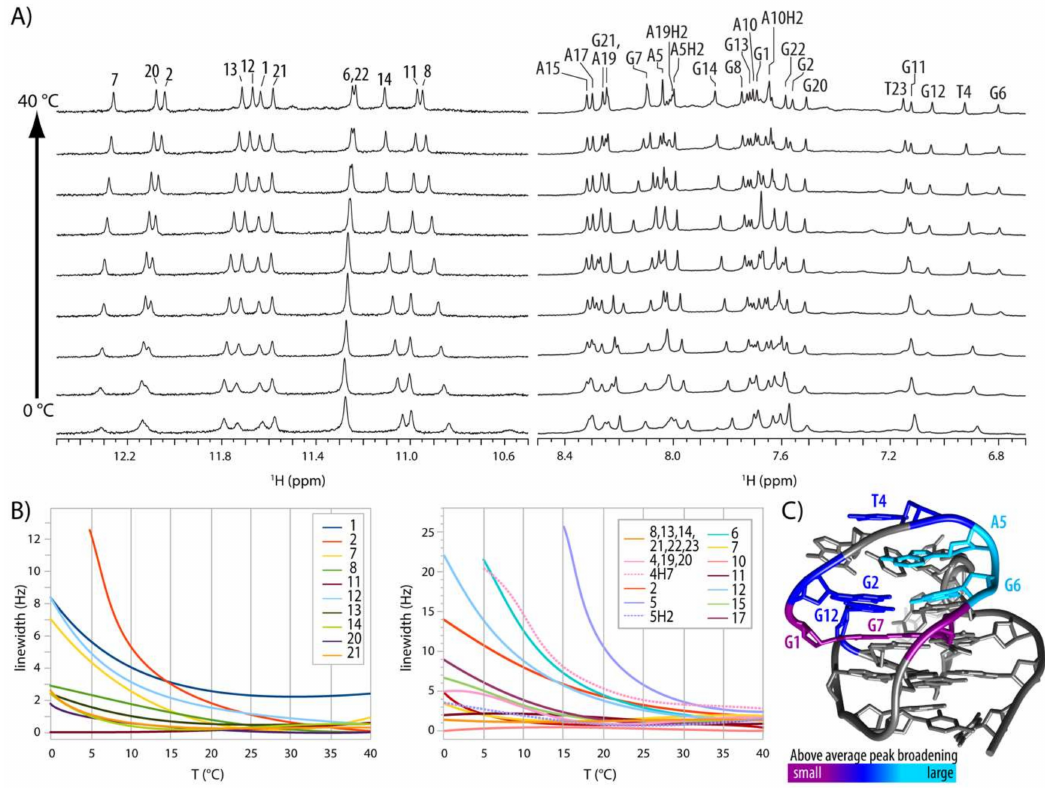
Figure 5. Spectral changes of HPV51 (1–4) as a function of temperature. ( A ) Imino and aromatic regions of 1D 1 H spectra in 5 ◦ C steps from 0 to 40 ◦ C. ( B ) Temperature dependency of signal width at half-height of imino (left) and aromatic and methyl protons (right). To estimate contributions other than change of temperature and viscosity the minimal line broadening observed at certain temperature has been subtracted from measured values for specific residues. ( C ) Structure of HPV52 (1–4) with coloured residues displaying line-broadening above 10 and 15 Hz for imino and aromatic protons,